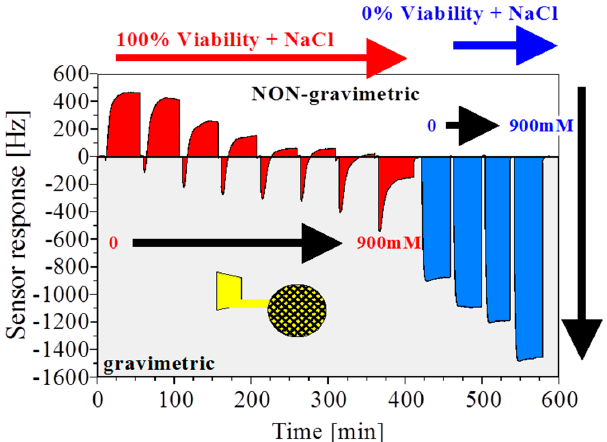
Figure 5. Differential sensor response with a S. cerevisiae imprinted layer on a grid electrode with an increasing concentration of NaCl in phosphate-buffered saline (PBS). All samples had a constant cell concentration of 10 7 cells/mL. Non-gravimetric responses are observed independent on the buffer conductivity. Increasing conductance causes a pseudo-gravimetric response due to capacitive coupling of the medium. The area under the response curve is colored in red for viable and blue for non-viable cells to guide the eye.